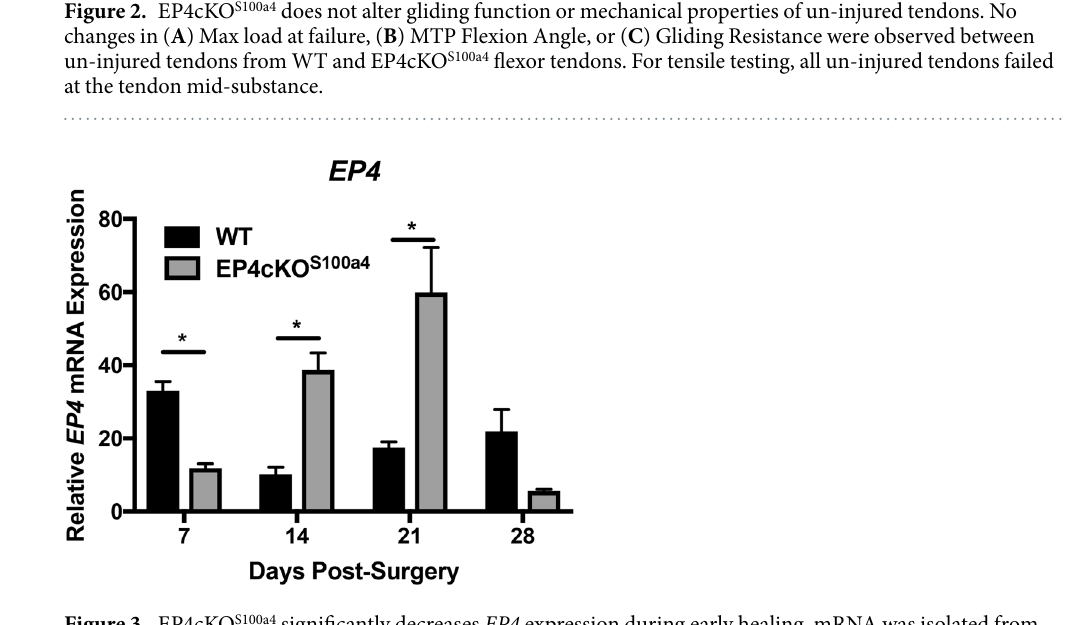
Figure 3. EP4cKO S100a4 significantly decreases EP4 expression during early healing. mRNA was isolated from EP4cKO S100a4 and WT tendon repairs between 7–28 days post-surgery. Relative EP4 expression was significantly decreased in EP4cKO S100a4 relative to WT at day 7, and was significantly increased on days 14 and 21 post- surgery. Expression was normalized to the internal control β -actin . ( * ) Indicates p <